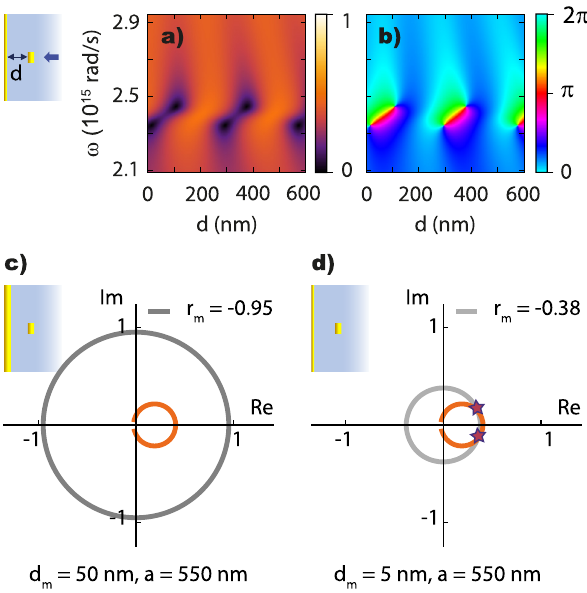
Figure 3: Calculated amplitude (a) and phase (b) response for the SalisburyscreeninFigure2jando),inwhichthere fl ectivity r m of the back re fl ector has been decreased to match the re fl ectivity of the weakly scattering array, such that singular points in re fl ection are retrieved. (c and d) Graphical construction of Eq. (20) in the complex plane, showing the trajectories that the right-hand and left-hand side (gray and orange respectively) of the equation trace out as a function of frequency. (c) When a weakly scattering metasurface (pitch550nm)iscombinedwithahighlyre fl ectivebackre fl ector,the circles traced out by r m e inkd (gray) and − r a ( ω ) / ( 1 + 2 r a ( ω )) (orange) do not intersect. (d) Reducing the back mirror re fl ectivity to that of a 5 nm Au layer results in crossing of the circles and retrieval of the singular points shown in (a) and